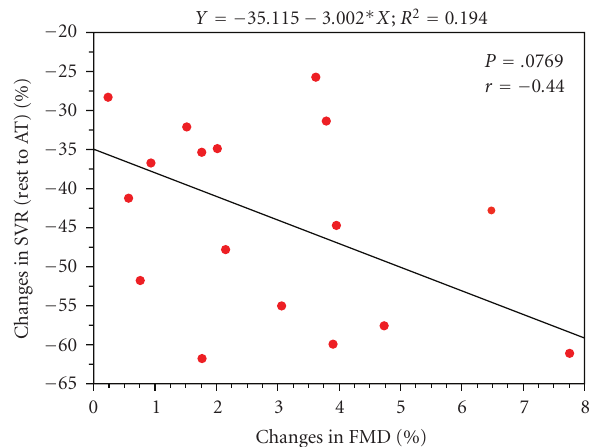
Figure 4: The correlation between flow-mediated vasodilation and changes in systemic peripheral vascular resistance during exercise in the patients not on ACE-inhibitors. FMD: flow-mediated vasodilation; SVR: systemic peripheral vascular resistance.